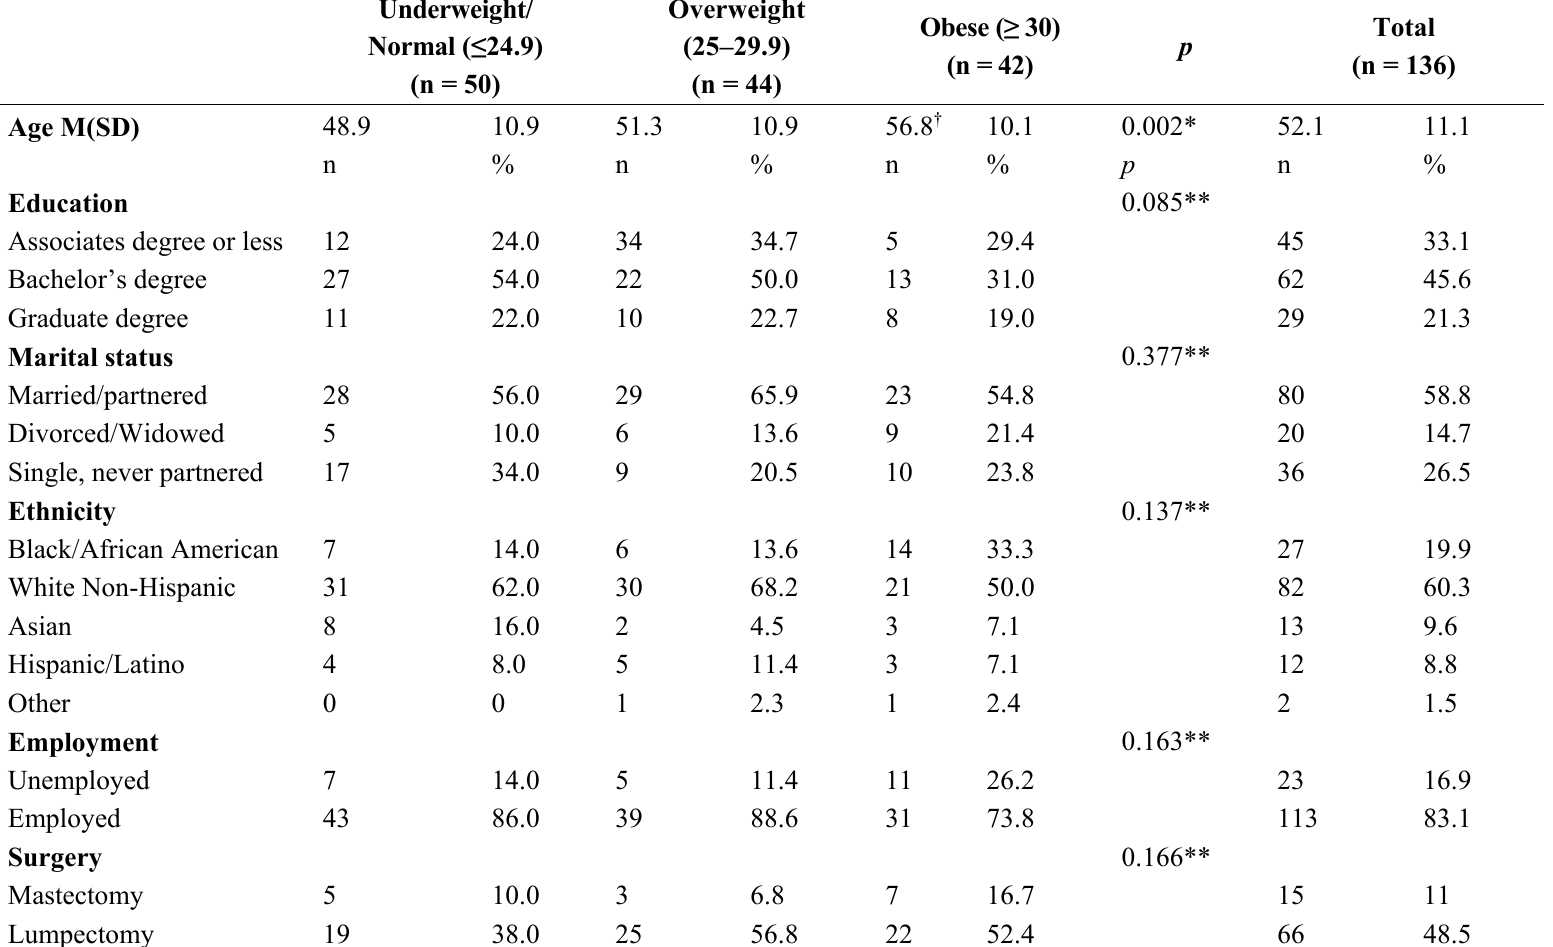
Table 2. Demographic and Clinical Characteristics by Pre-surgery Baseline BMI